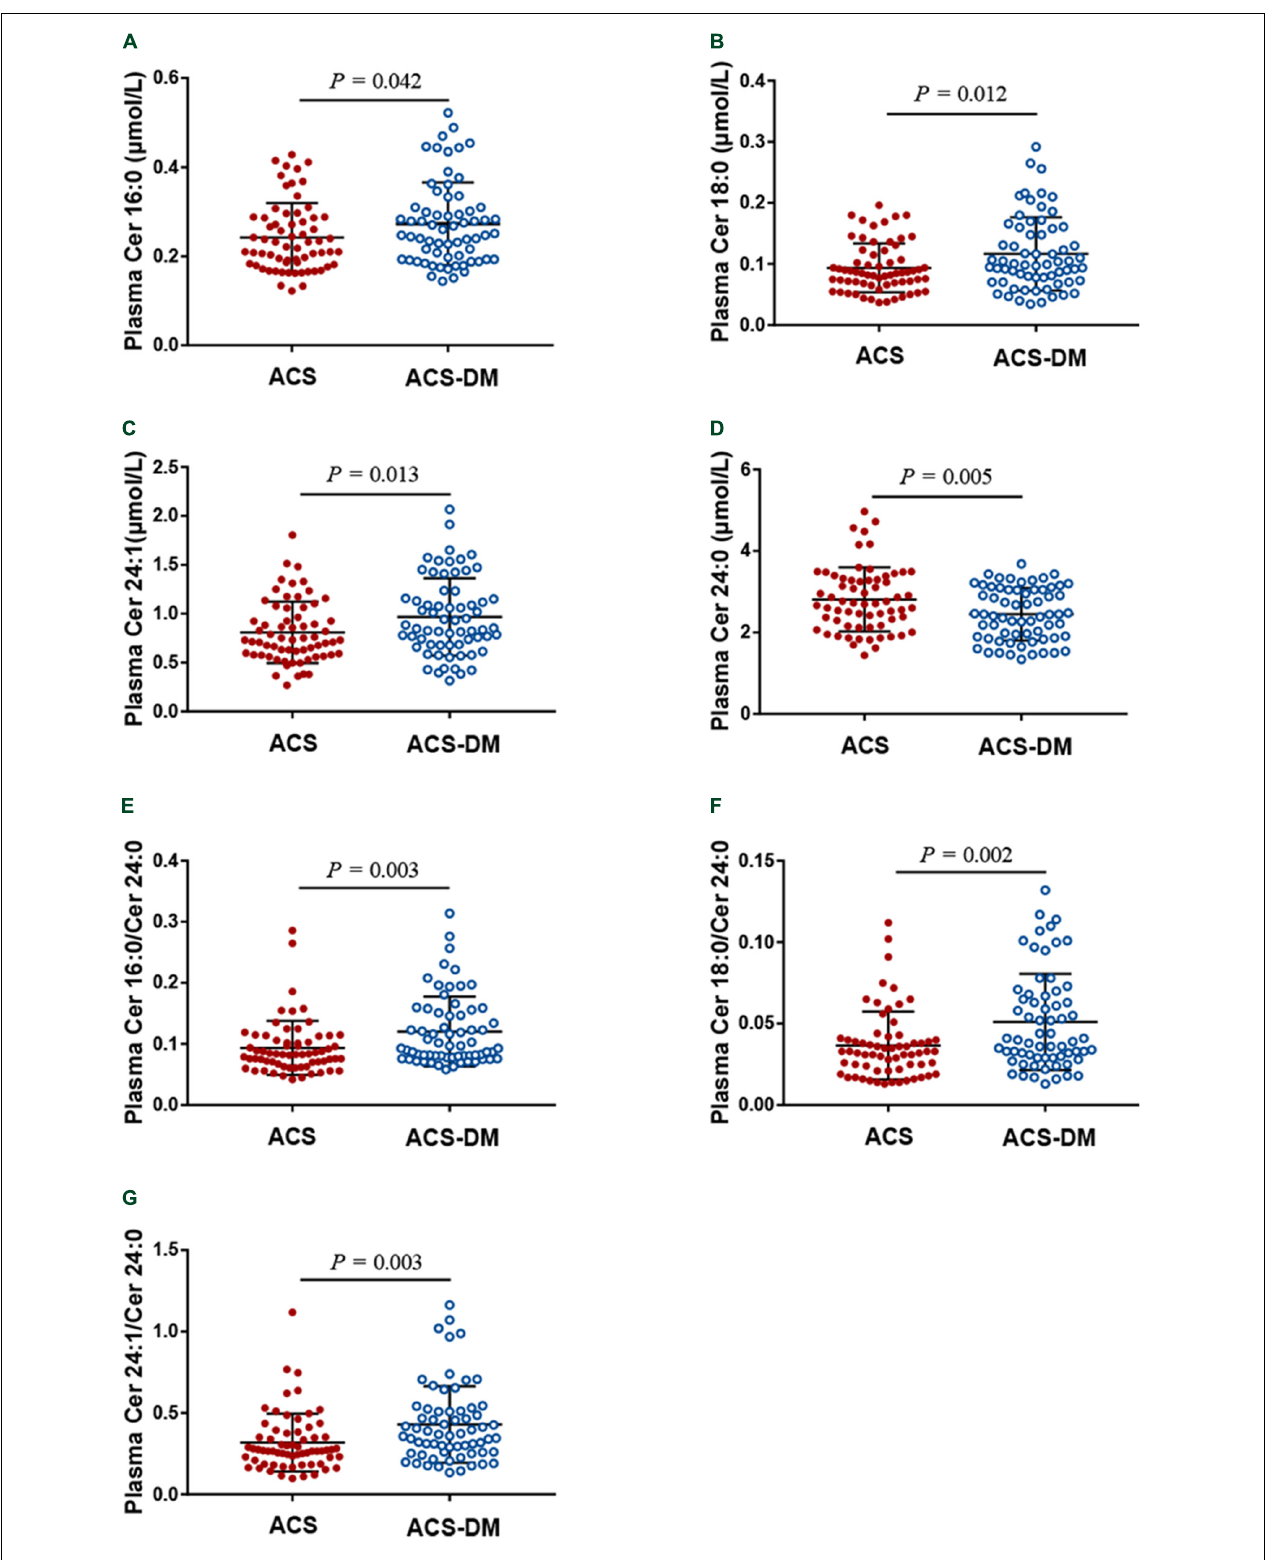
FIGURE 2 | (A–G) A comparison of the levels of ceramides in patients with acute coronary syndrome (ACS) and those with comorbid acute coronary syndrome and type 2 diabetes mellitus (ACS-DM).